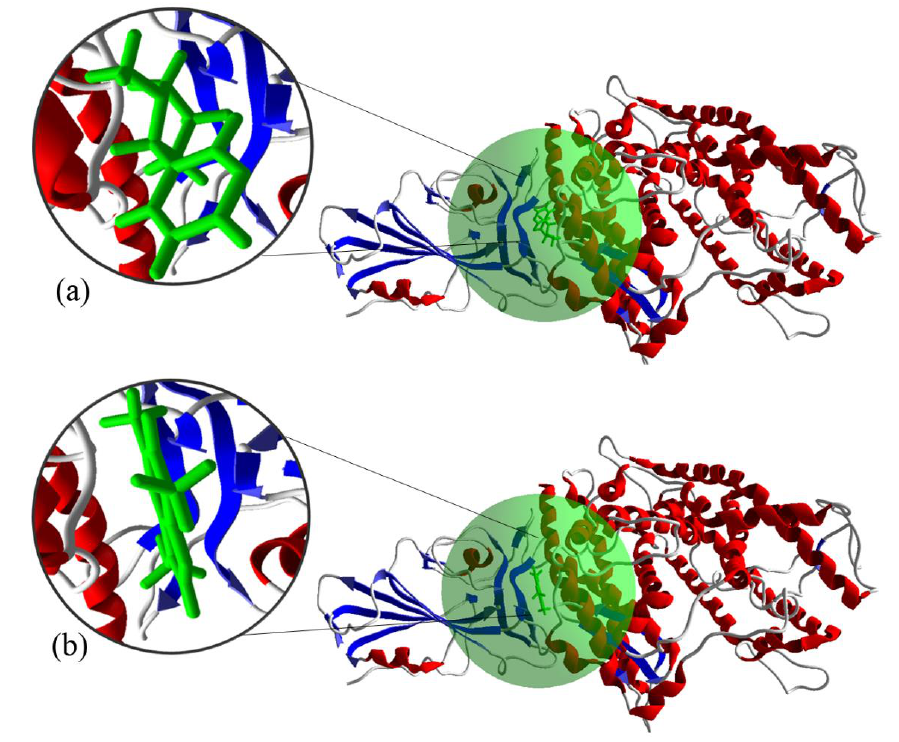
Figure 3. Interaction between ACE2/SARS-CoV-2-CTD (6LZG) complex with ( a ) nicotine and ( b ) caffeine. The green regions (and the corresponding magnified inlays) represent the active sites.